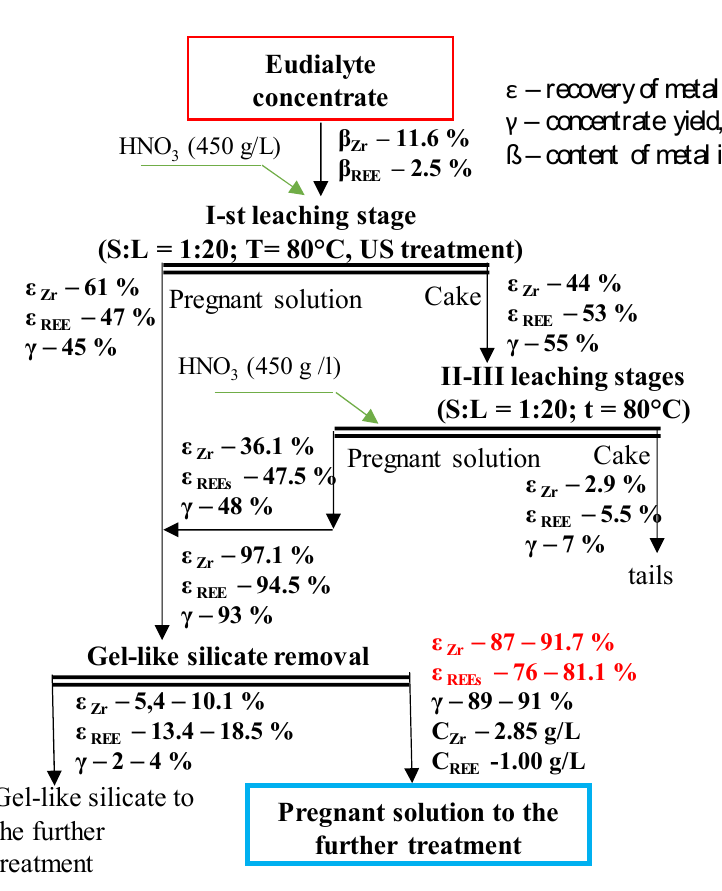
Figure 7. The developed scheme of eudialyte concentrate leaching.